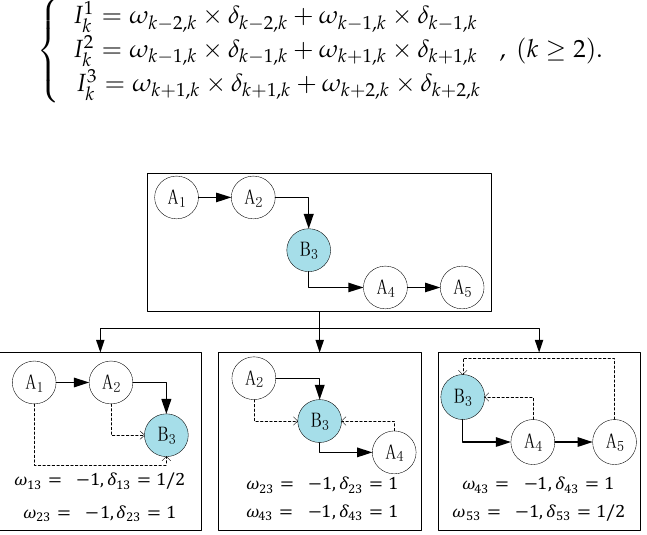
Figure 7. Example of calculating the final influence factor.